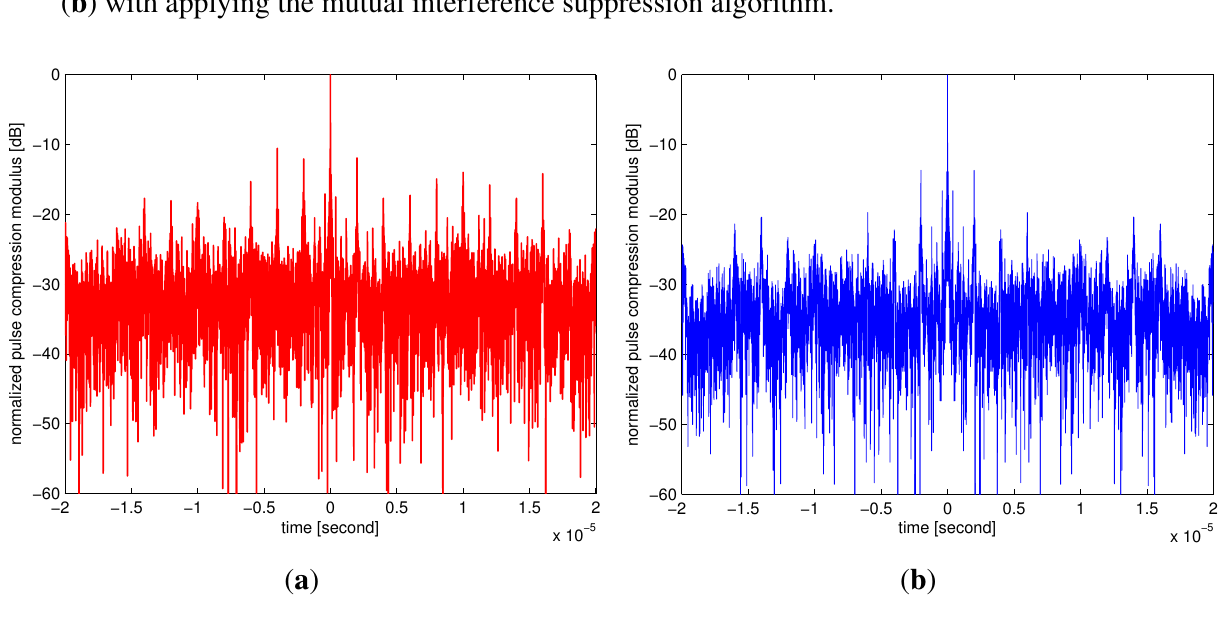
Figure 10. Comparative pulse compression results for two radars using the OFDM chirp diverse waveforms: ( a ) without applying the mutual interference suppression algorithm; ( b ) with applying the mutual interference suppression algorithm.